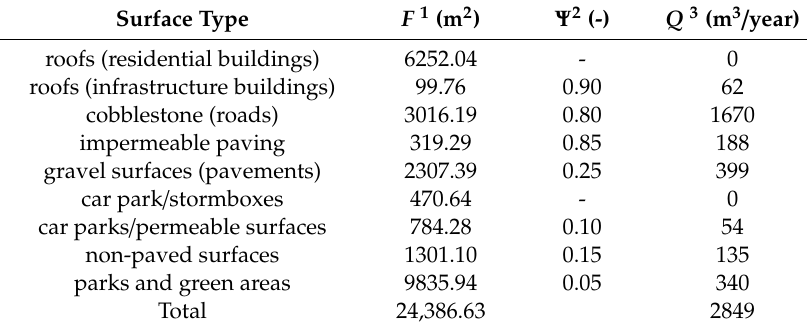
Table 12. Surface runo ff after introducing the solutions.